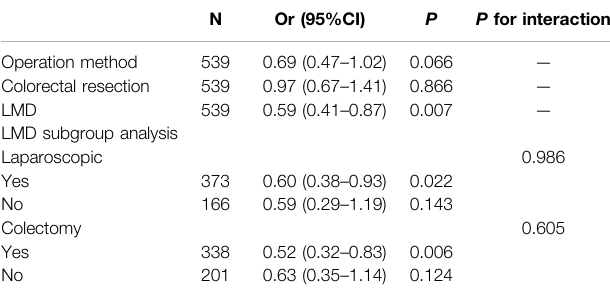
TABLE 5 | Characteristics of paired